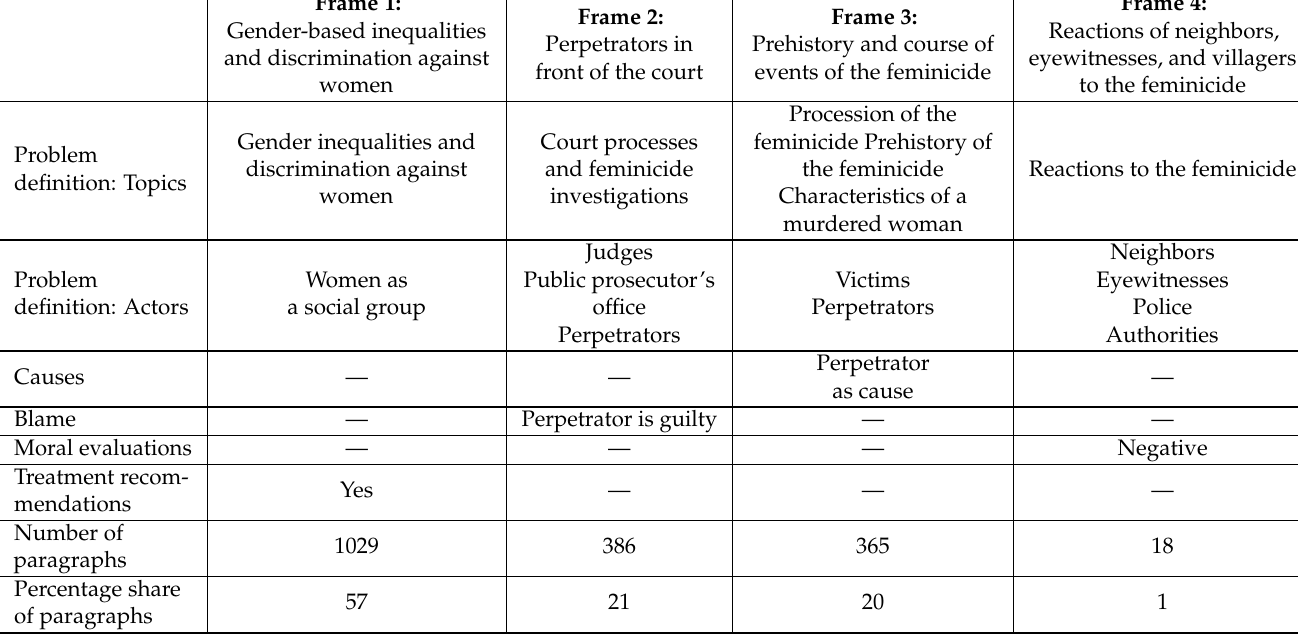
Table 2. Frames in feminicide coverage of the four Colombian newspapers under